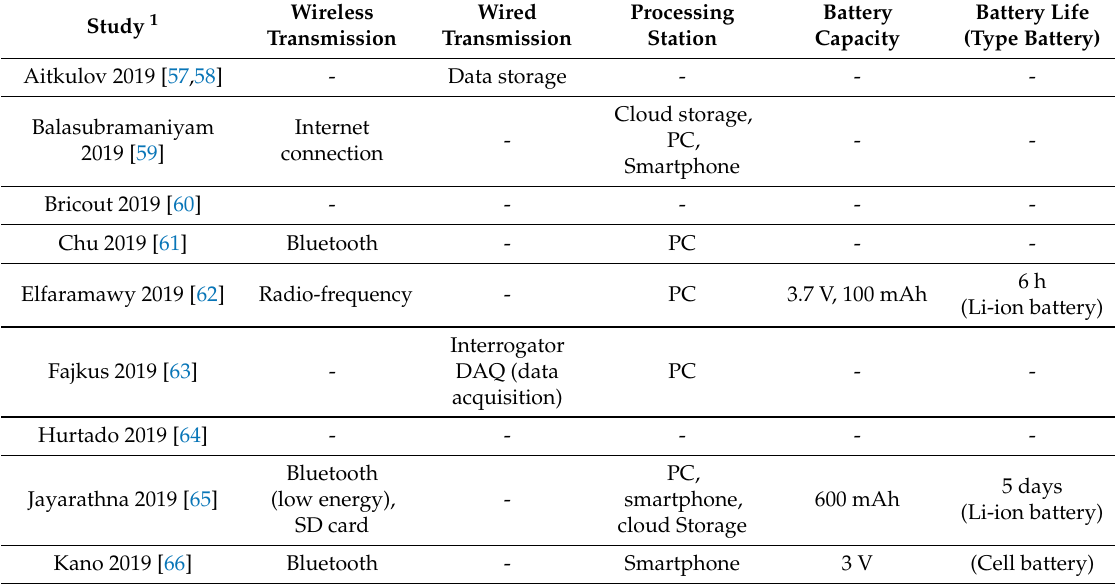
Table 4. Analysis of transmission technology, processing station, and energy autonomy for studies in the wearable